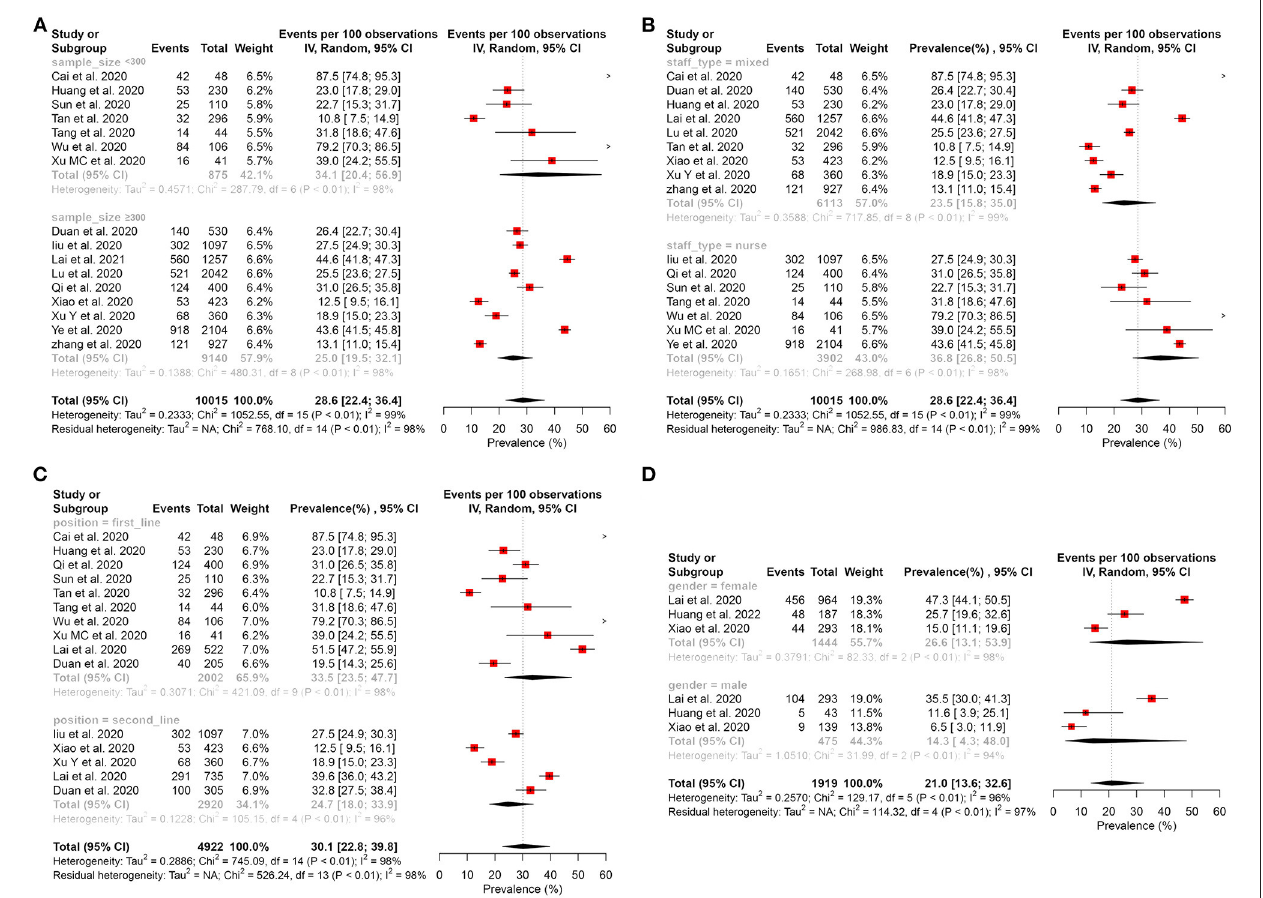
FIGURE 5 | Subgroup analysis of the prevalence of anxiety among healthcare workers. (A) Subgroup analysis stratification by sample size. (B) Subgroup analysis stratification by staff type. (C) Subgroup analysis stratification by position. (D) Subgroup analysis stratification by gender.